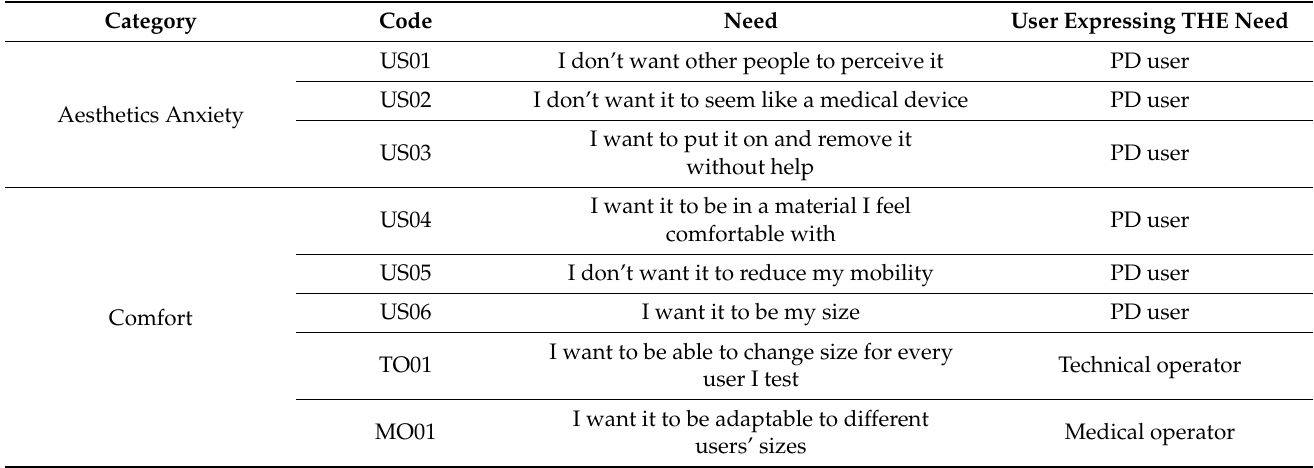
Table 1. Users’ needs listed by